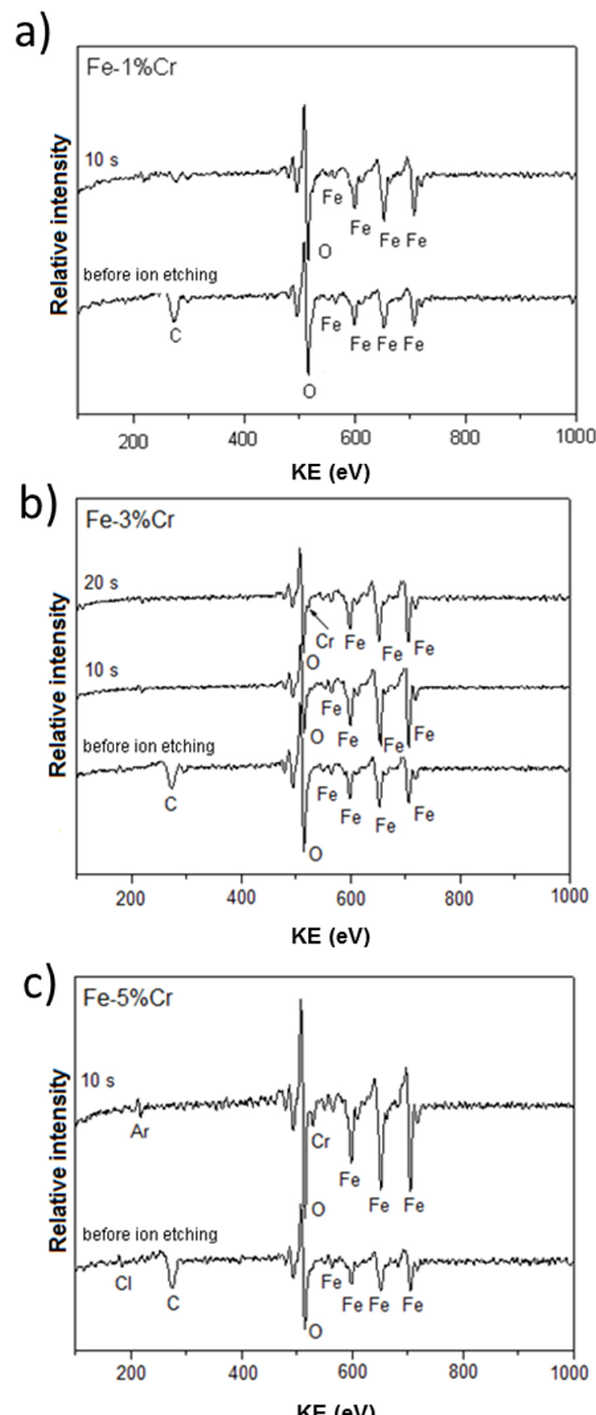
Figure 6. AES analysis of the chemical composition of Fe-Cr alloys (( a ) 1%, ( b ) 3%, and ( c ) 5% of Cr) after chronoamperometric measurements at a constant potential ( E vs. SHE = − 0.7V) in 0.1 M Na 2 SO 4 at 80 °C.